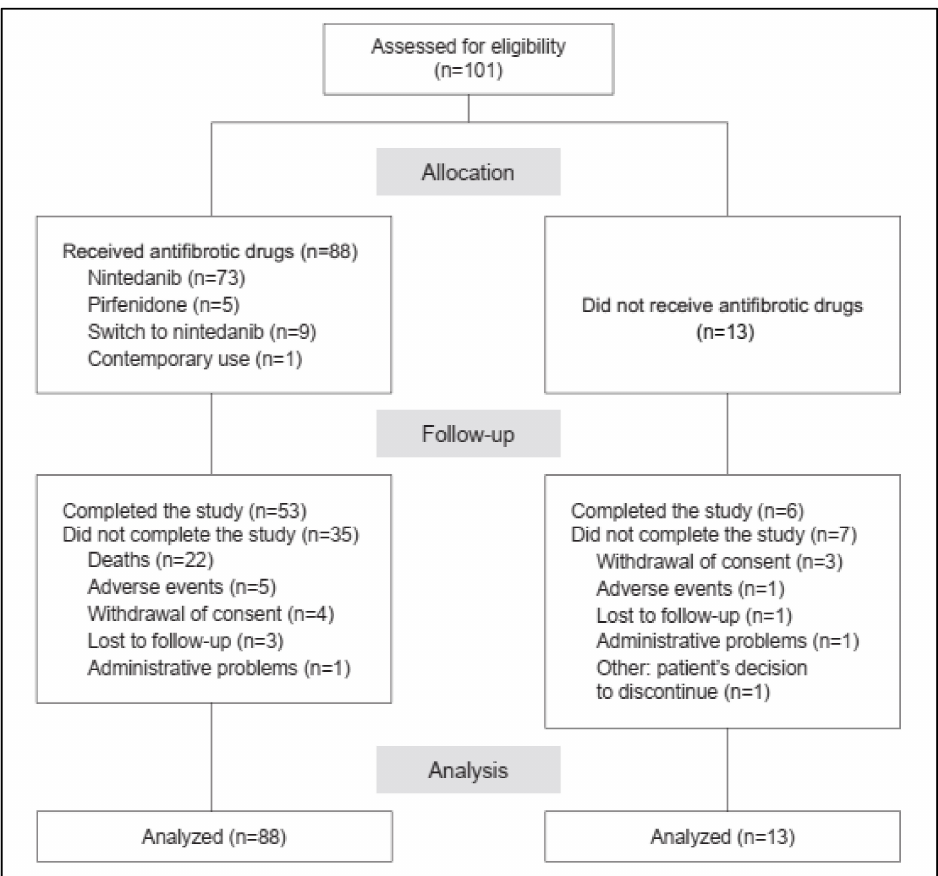
Figure 1. A summary of patient disposition. A total of 101 eligible patients were recruited and allocated to the treated group receiving the antifibrotics nintedanib and pirfenidone (n = 88) or the untreated group (n =